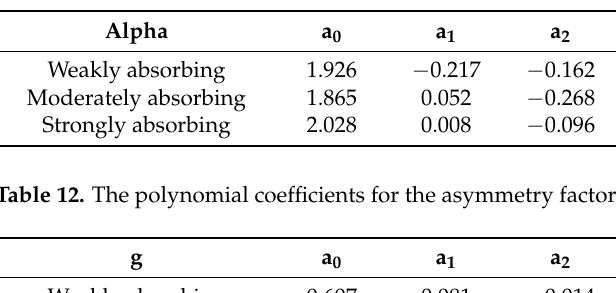
Table 11. The polynomial coefficients for the Angstrom coefficient.